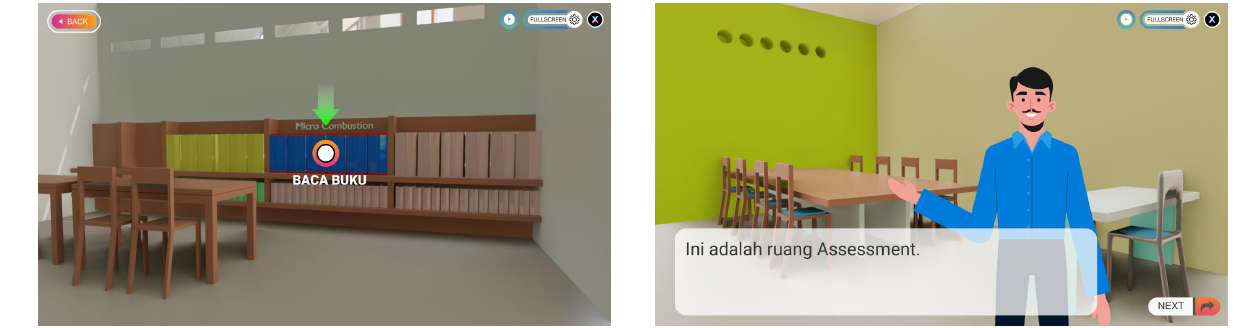
Figure 5: Library room